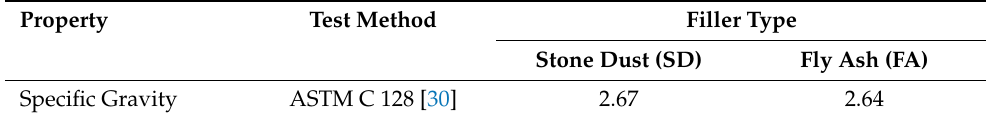
Table 3. Specific gravity of fillers.